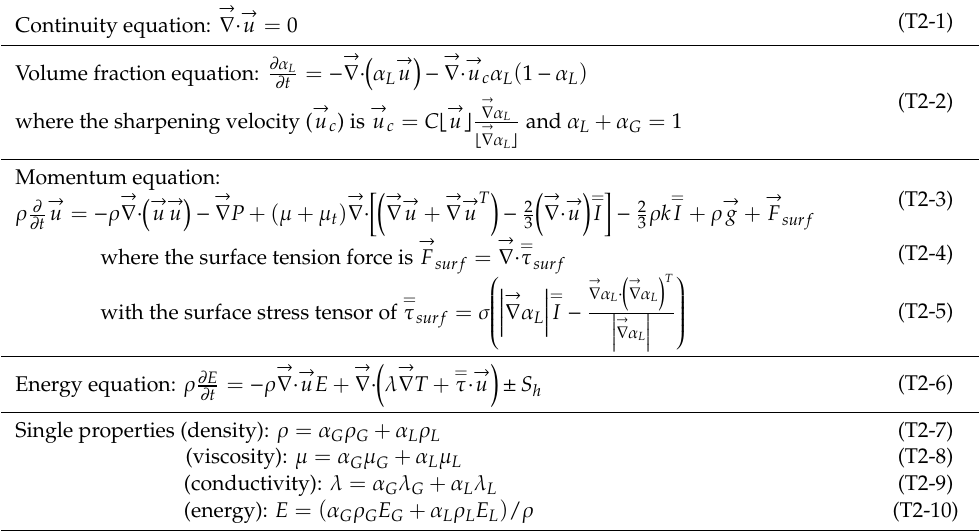
Table 2. Volume of fluid (VOF)-CFD model for gas-liquid phase [33,50]. → ∇· → u = Continuity equation: